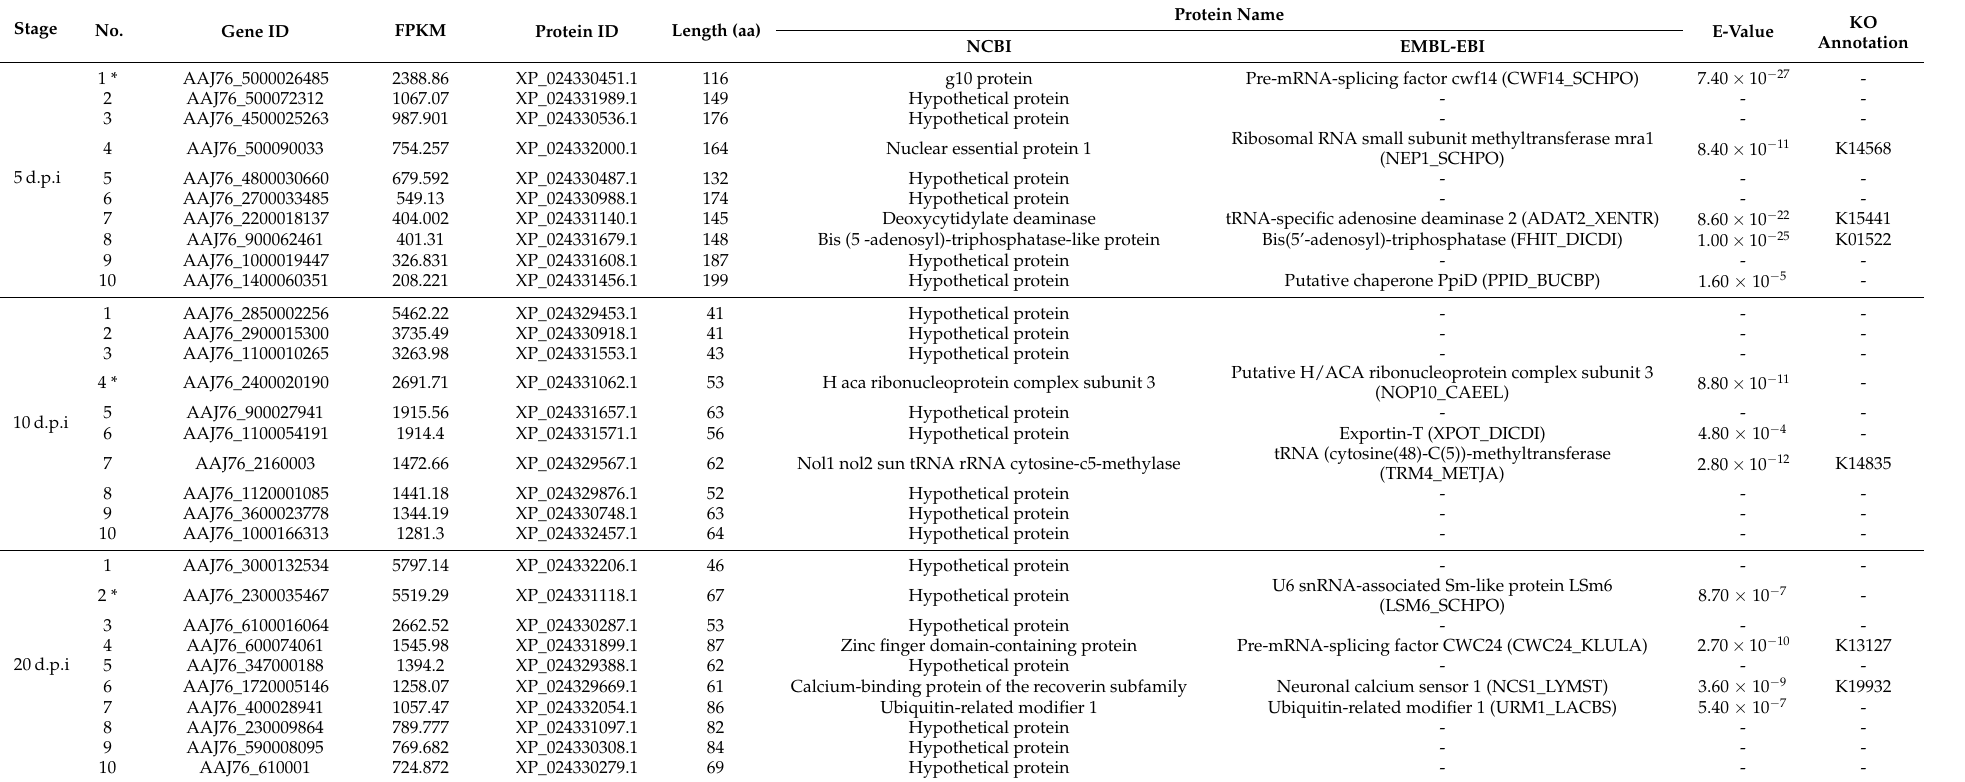
Table 3. List of the top 10 ranked stage-specific genes at different times